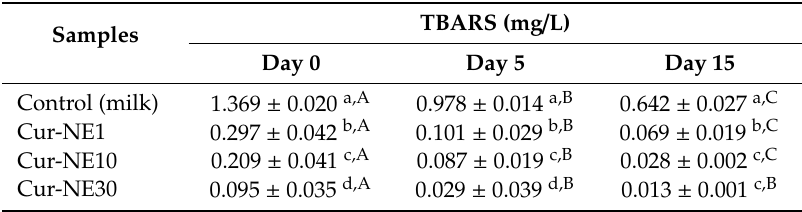
Table 4. Thiobarbituric acid reactive substances (TBARS) values (mg / L) of entrapped curcumin loaded in NEs in the presence of milk at 0, 5, and 15